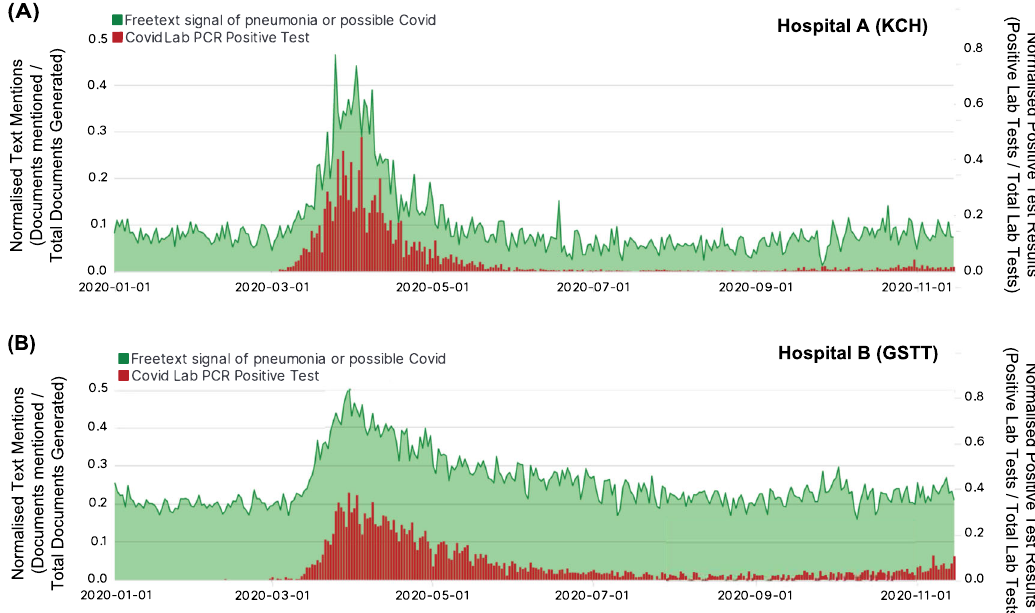
Fig. 1 Timeline of freetext signal for Covid-like symptoms from clinician text entries for two major London hospitals during the Covid pandemic. A Hospital A (Kings College Hospital, KCH) freetext signal (Green) and positive laboratory tests normalised against negative tests (Red) from 1st January 2020 till 12 November 2020; B Hospital B (Guys & St Thomas ’ Hospital, GSTT) freetext signal (Green) and positive laboratory tests normalised against negative tests (Red) from 1st January 2020 till 12 November 2020. KCH text signal was derived from both A&E and inpatients, while GSTT text signal was derived only from inpatients (A&E data not accessible). A fi gure with extension of the time period into January 2021 is available in Supplementary Fig.